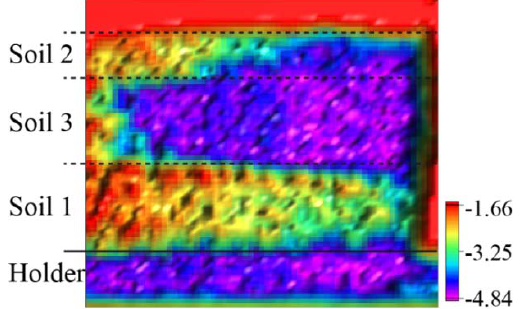
Figure 10. The transmission image of the first three soil samples with a logarithmic scale in arbitrary units. From top to bottom: Soil 2, Soil 3 and Soil 1. The image size is 60 mm by 60 mm.